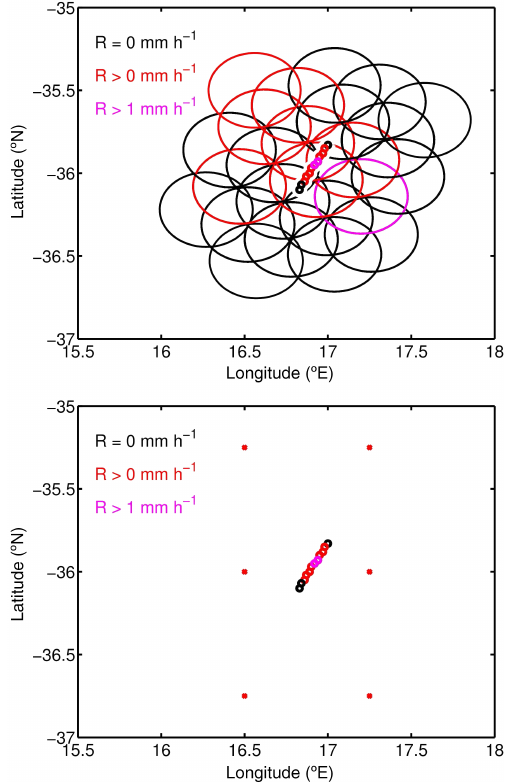
Figure 3. Examples of collocated data, which have been merged to events for HOAPS (top) and ERA-Interim (bottom). HOAPS’ footprints are indicated by the large circles, observations by ◦ , and ERA-Interim grid points by • . Colours indicate the rain rates, R. HOAPS data are from day 338 in 1995, min 1272; collocated ob- servations are from min 1235 to 1315. In the case of ERA-Interim, estimates are from day 338, min 1260 and 1440; collocated obser- vations are from day 338, min 1227 to